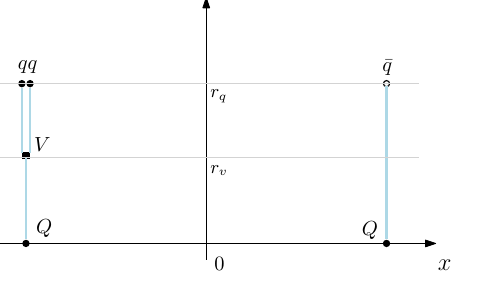
and E (II) at k = − 1 e 1 4 . Right: ∆ E QQq QQq 4